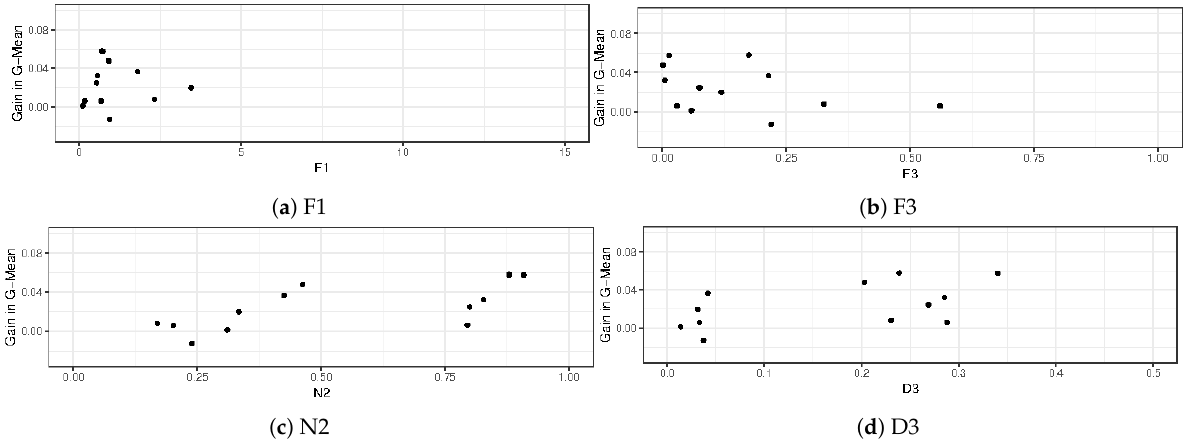
Figure 7. Graphs that represent the gain of G-Mean using the B-FIS in the UCI datasets by the different complexity measures. In the case of F1 and F3, low values represent high class overlapping, while, for N2 and D3, low values represent low class